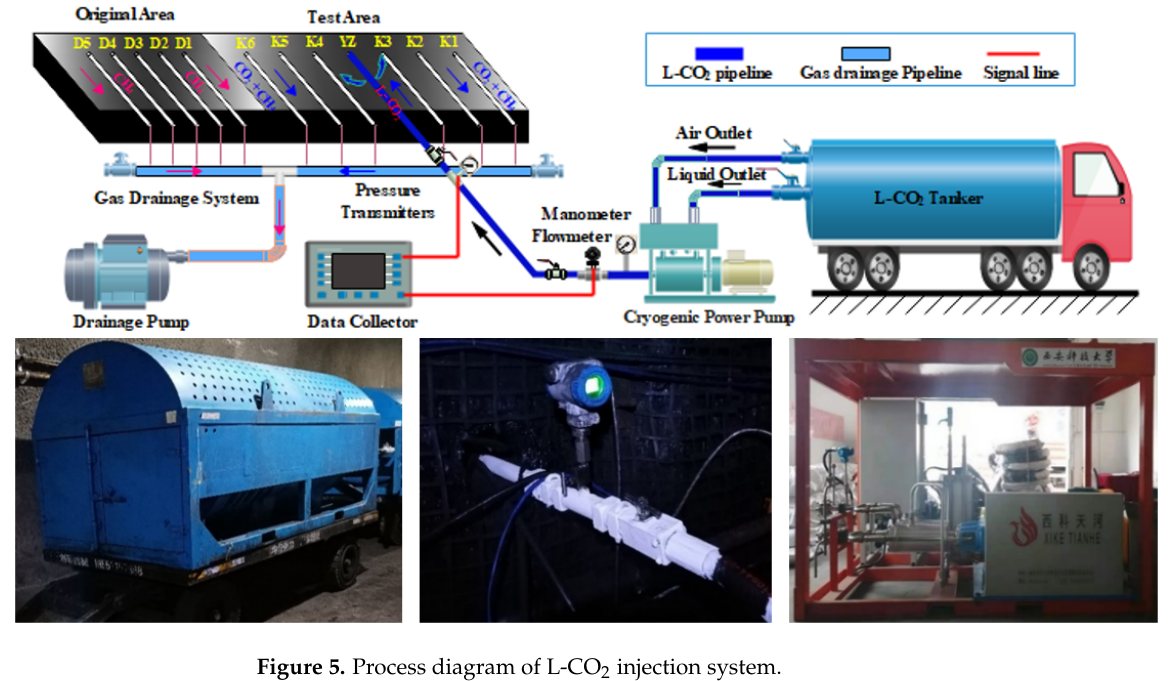
Figure 5. Process diagram of L-CO 2 injection system.